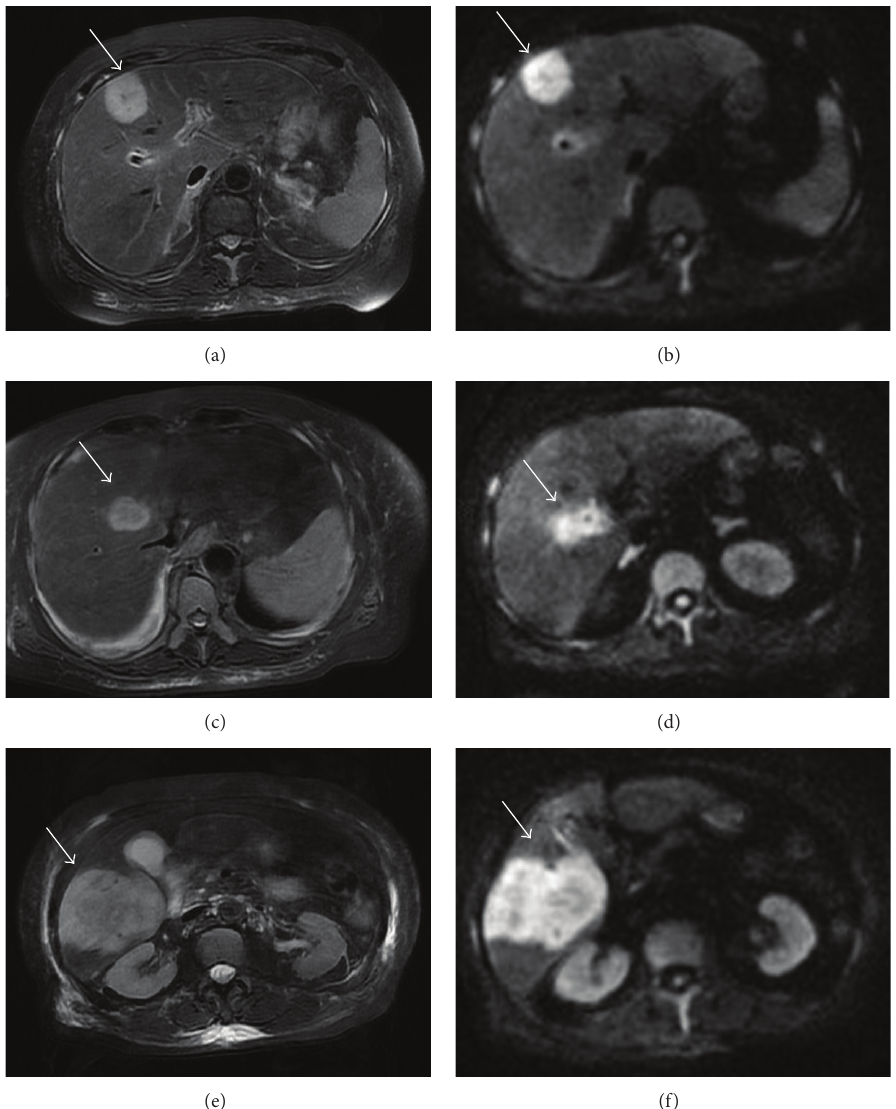
Figure 3: Noncontrast abdominal magnetic resonance imaging. Masses, 3.2 cm, 7 cm, and 2.2 cm in size, were revealed at segments 5, 6, and 8, respectively ((a)–(f)). These masses exhibited high signal intensity on T2- and diffusion-weighted imaging. Penetrating vessels were evident among the masses, suggesting hepatic